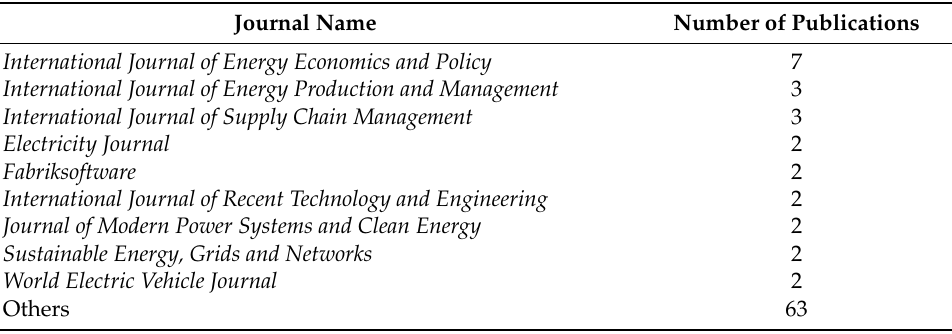
Table 7. The number of publications in each journal indexed in Scopus.